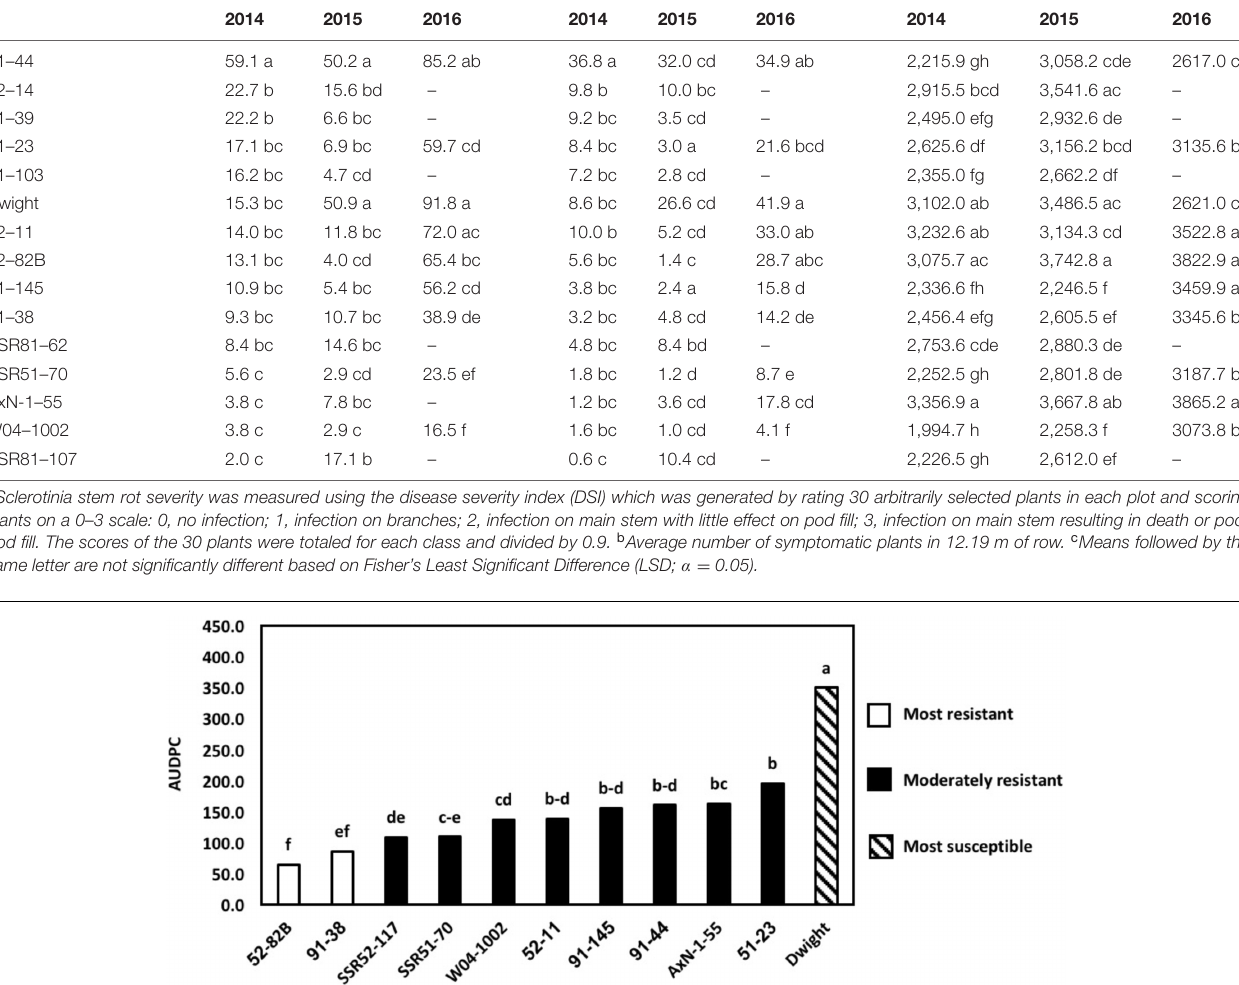
TABLE 5 | Sclerotinia stem rot severity and incidence, and yield of soybean breeding lines and cultivars tested in a Sclerotinia stem rot nursery at University of Wisconsin’s Hancock Agricultural Research Station, 2014–2016. Breeding line or cultivar